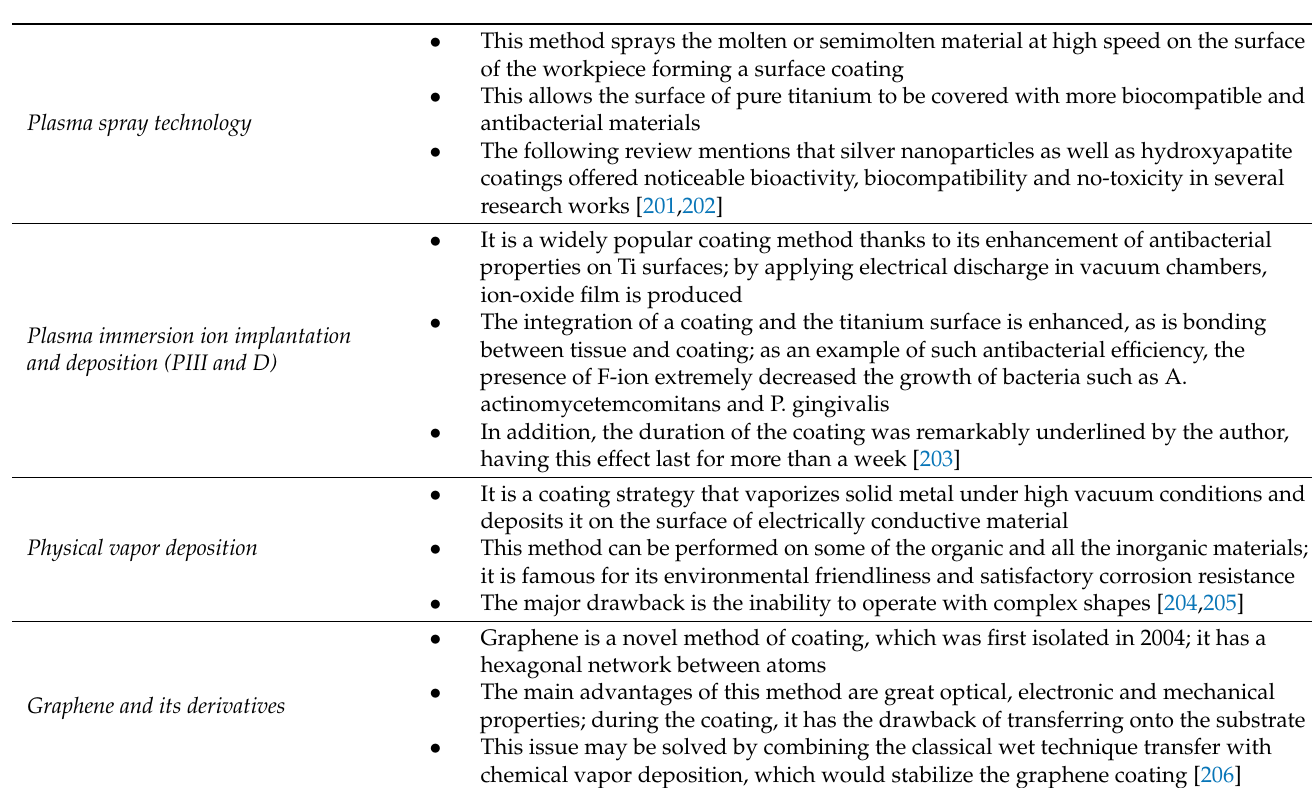
Table 13. List of physical modification